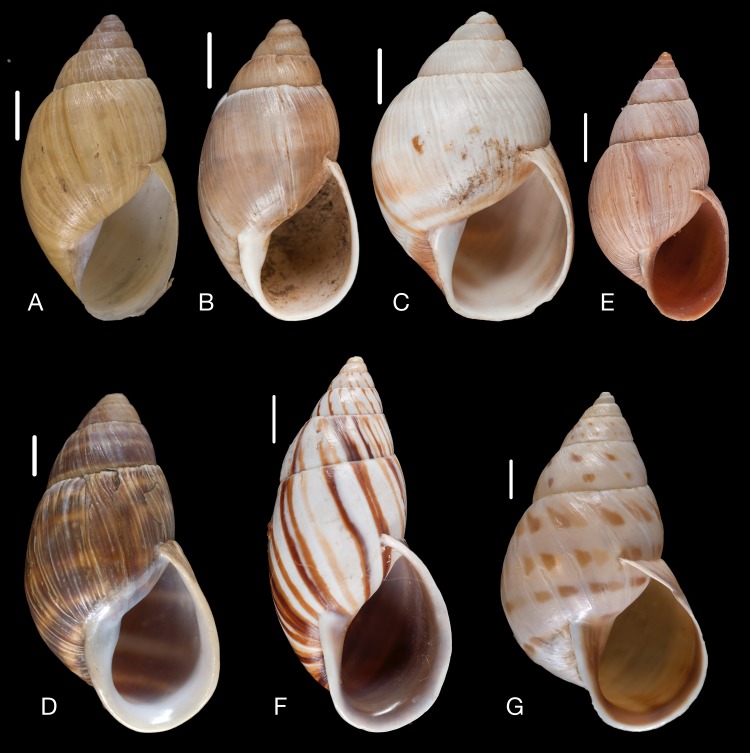
Material collected by the CCP.(A–G) Bulimulidae. Kuschelenia (Bocourtia) cotopaxiensis (Pfeiffer, 1853), MNCN 15.05/13142, (A) ventral view; Kuschelenia (Bocourtia) petiti (Pfeiffer, 1846), MNCN 15.05/13401, (B) ventral view; Kuschelenia (Kuschelenia) revinctus (Hupé, 1857), MNCN 15.05/76198, (C) ventral view; Kuschelenia (Kuschelenia) tupacii (d’Orbigny, 1835), MNCN 15.05/21241, (D) ventral view; Naesiotus quitensis (Pfeiffer, 1848), MNCN 15.05/13143, (E) ventral view; Neopetraeus lobbii (Reeve, 1849), MNCN 15.05/13464, (F) ventral view; Neopetraeus tessellatus (Shuttleworth, 1852), MNCN 15.05/13370, (G) ventral view. Scale 5 mm.